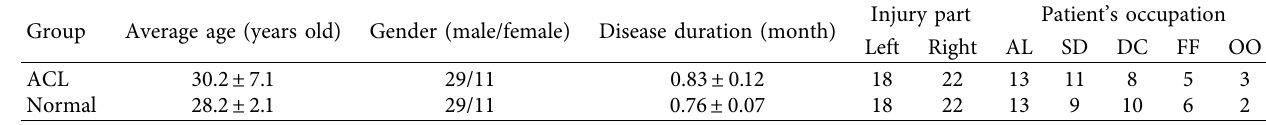
Table 1: The general information of selected